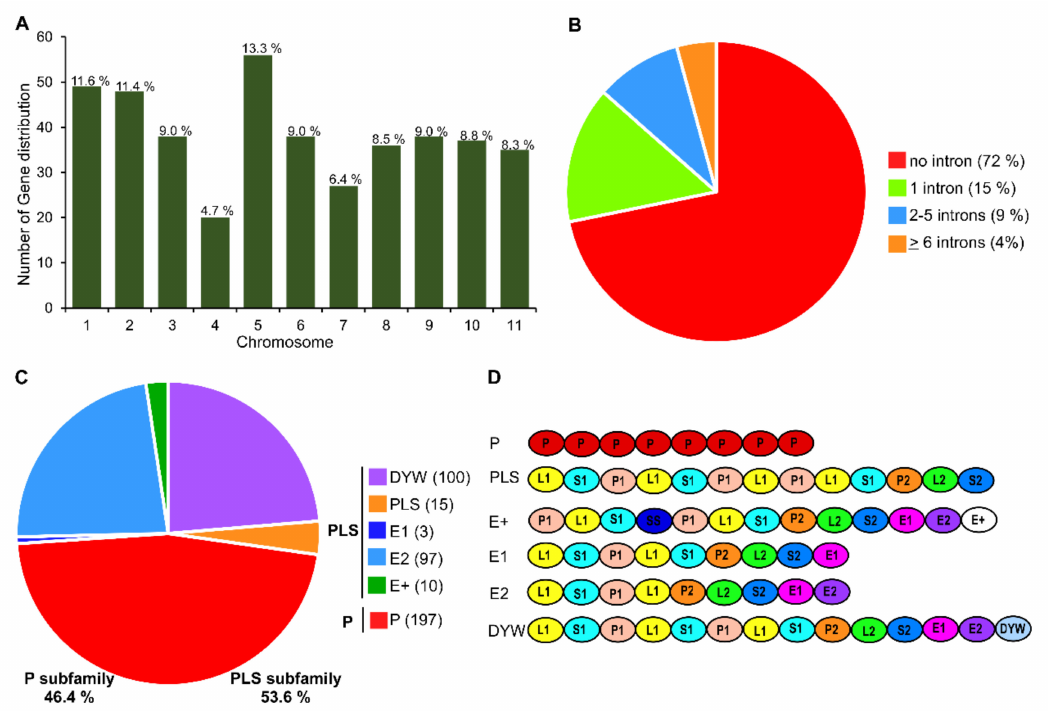
Figure 1. Number, distribution, and structures of Pentatricopeptide-repeat ( PPR ) genes in watermelon. ( A ) Number of ClaPPR genes in each chromosome. ( B ) Number of introns in ClaPPR genes. ( C ) Number of ClaPPR proteins belonging to the P subfamily and PPR-like long and short (PLS) subfamily with subgroups. ( D ) Typical motif structures of ClaPPR proteins from di ff erent subfamilies and